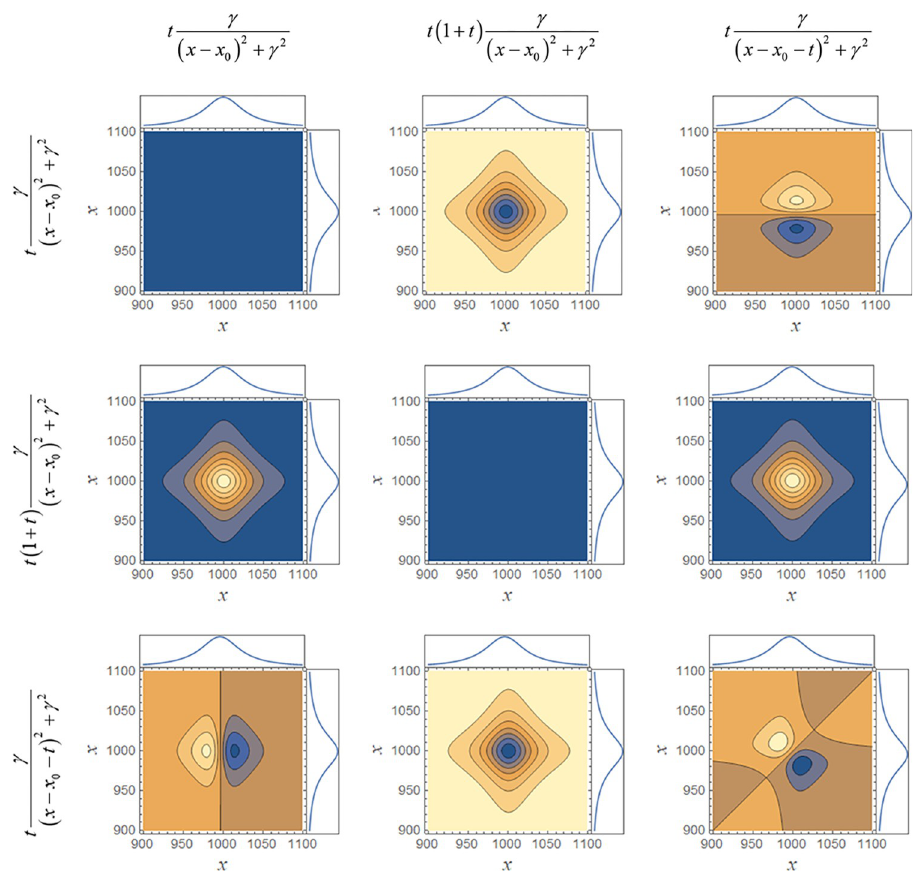
Fig 4. Asynchronous 2D correlation maps for the mixture of different functions. For all parameters (except the constants a and b ) the same values were chosen for both series.